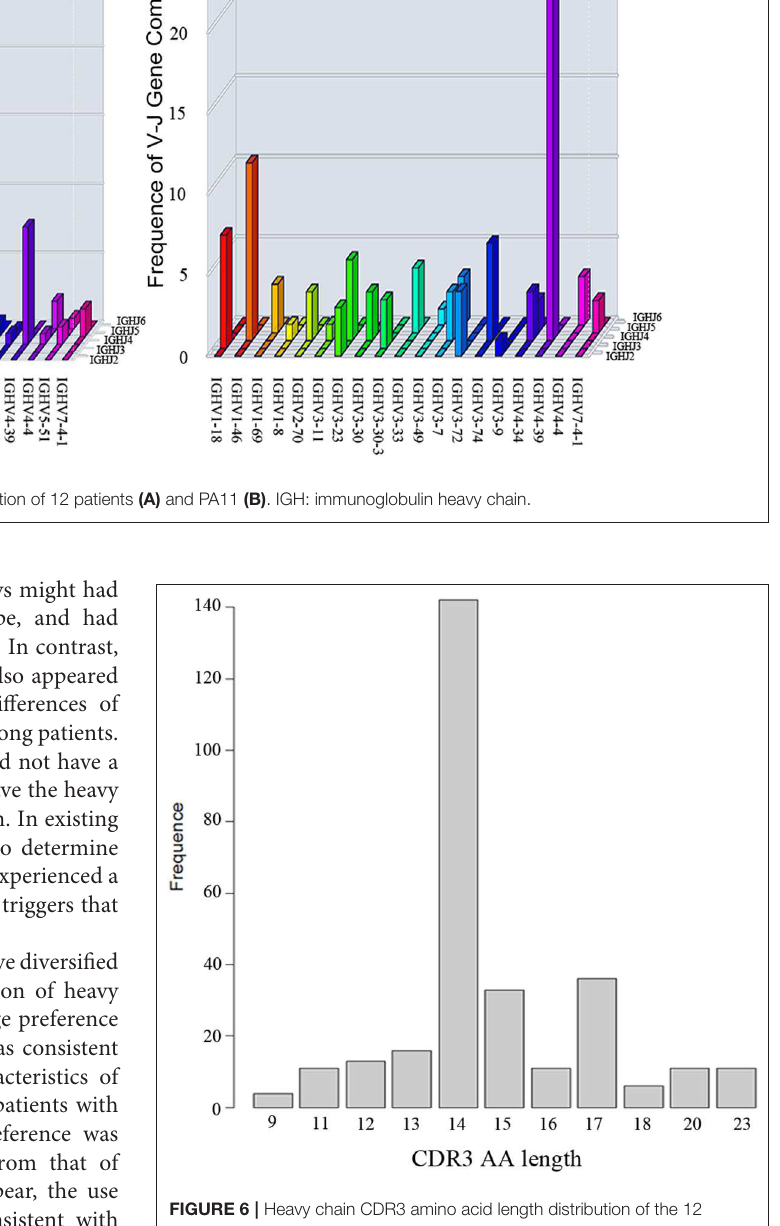
FIGURE 6 | Heavy chain CDR3 amino acid length distribution of the 12